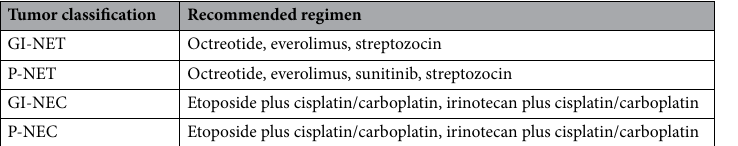
Table 1. Definitions of guideline-adherent first-line systemic therapy regimens used in patients with GEP-NEN in this study. GI-NEC gastrointestinal neuroendocrine carcinoma, GI-NET